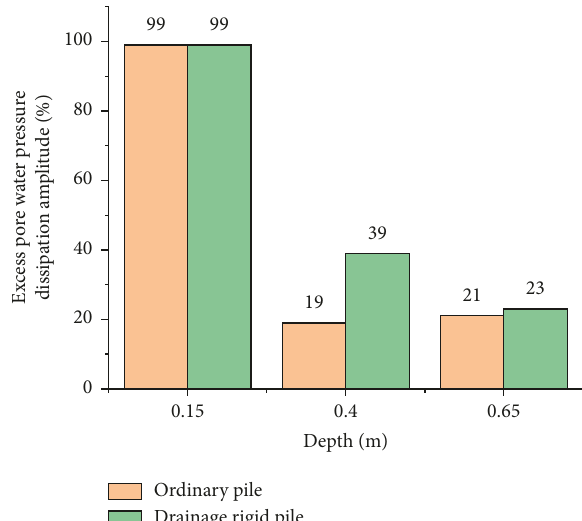
Figure 17: Dissipation magnitude of excess pore water pressure under the disposal of ordinary piles and drainage rigid piles in the simultaneous fracturing blast vibration test.